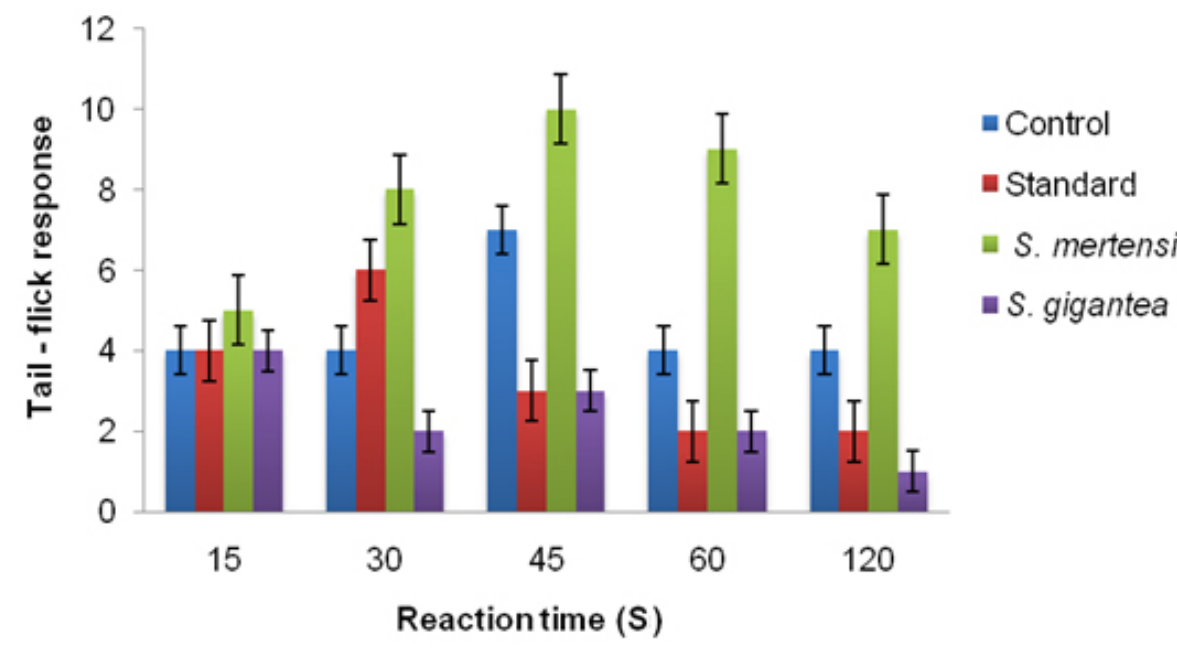
Figure 3. Analgesic activities by tail-flick response of male albino mice to S. mertensii and S. gigantea extract at 2 mg.kg –1 of 20 ± 2 g.